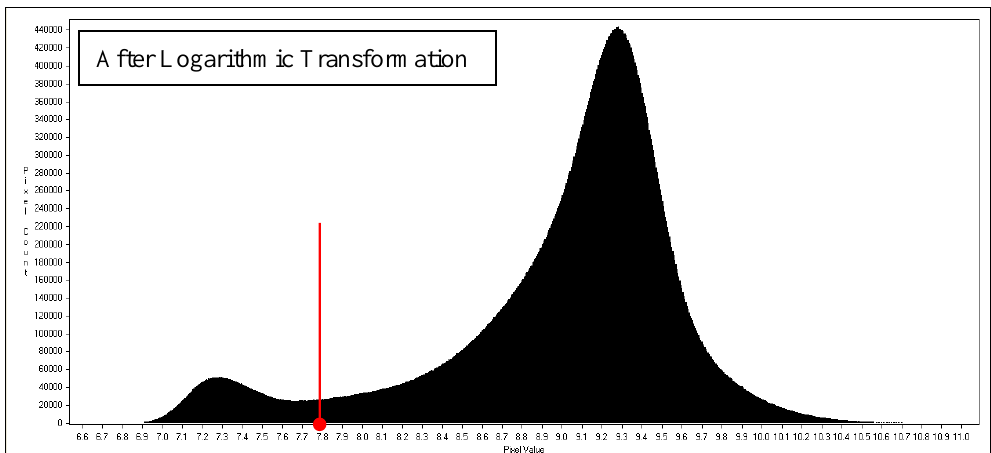
Figure 3. Histogram after logarithmic transformation.